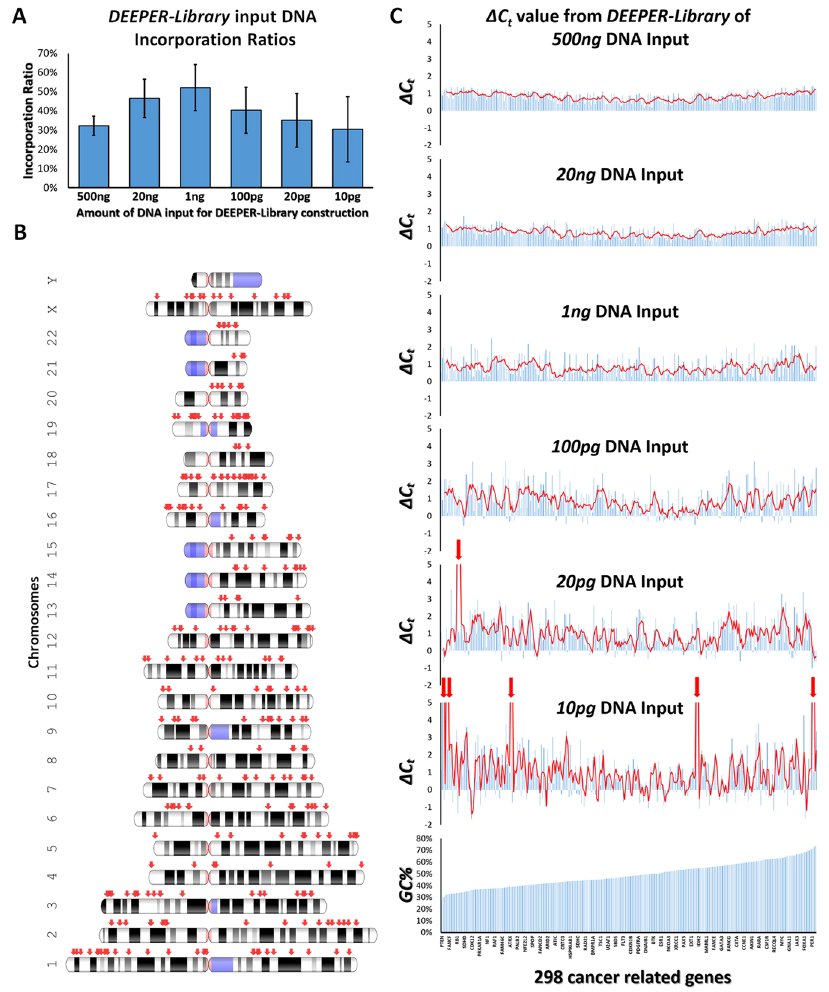
Figure 3. Performance evaluation of DEEPER-Library . ( A ) Incorporation ratios of single stranded DNA in DEEPER-Library pipeline. The fractions of DNA molecules that were incorporated into DEEPER-Library construction from different amounts of starting DNA (500 ng, 20 ng, 1 ng, 100 pg, 20 pg and 10 pg genomic DNA) were plotted. Ratios were measured by Qubit ® ssDNA Assay Kit on a Qubit unit (ThermoFisher Scientific). ( B ) Genomic locations of 298 cancer related genes on human chromosomes (indicated by red arrows). ( C ) Six Δ C t values for each of the 298 genes were calculated by real-time PCR assays detecting gene abundance difference between 500 ng original genomic DNA input and 500 ng DEEPER-Library final products created from six different amounts (500 ng, 20 ng, 1 ng, 100 pg, 20 pg and 10 pg) of input genomic DNA. The 298 genes were ranked by the GC% of their amplicons and gene names were shown on the x-axis from low GC% (left) to high GC%